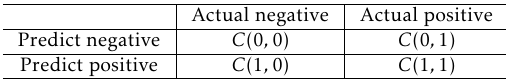
Table 1. Cost Matrix for Binary